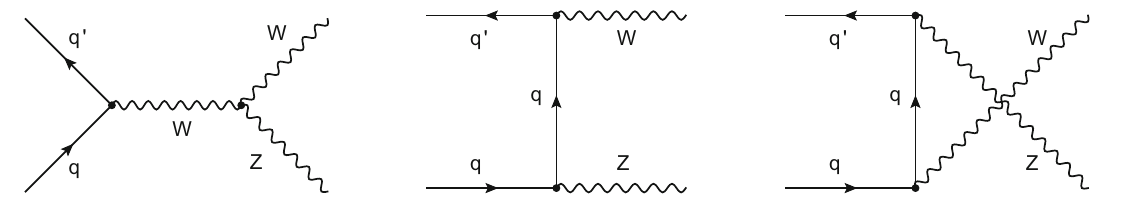
Fig. 1 Leading-order Feynman diagrams for WZ production in proton–proton collisions. The three diagrams represent contributions from ( left ) s -channel through TGC, ( middle ) t -channel, and ( right ) u